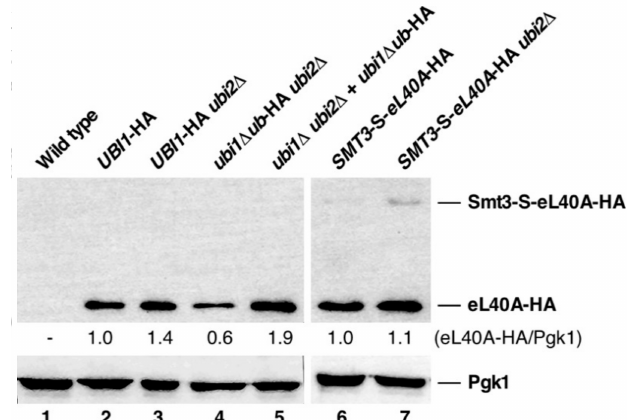
Figure 4. Analysis of the protein levels of eL40A-HA. A wild-type control strain (lane 1) and strains with the indicated relevant genotypes, expressing C-terminally HA-tagged eL40A from the di ff erent precursor constructs, either from the genomic locus (lanes 2 , 3 , 4 , 6 , and 7 ) or from a centromeric plasmid (lane 5 ), in a wild type UBI2 or a ubi2 ∆ null mutant background, were grown in liquid YPD medium at 30 ◦ C. Total cell extracts were prepared and subjected to western analysis using anti-HA and anti-Pgk1 (loading control) antibodies. The mature eL40A-HA and the Smt3-S-eL40A-HA precursor are